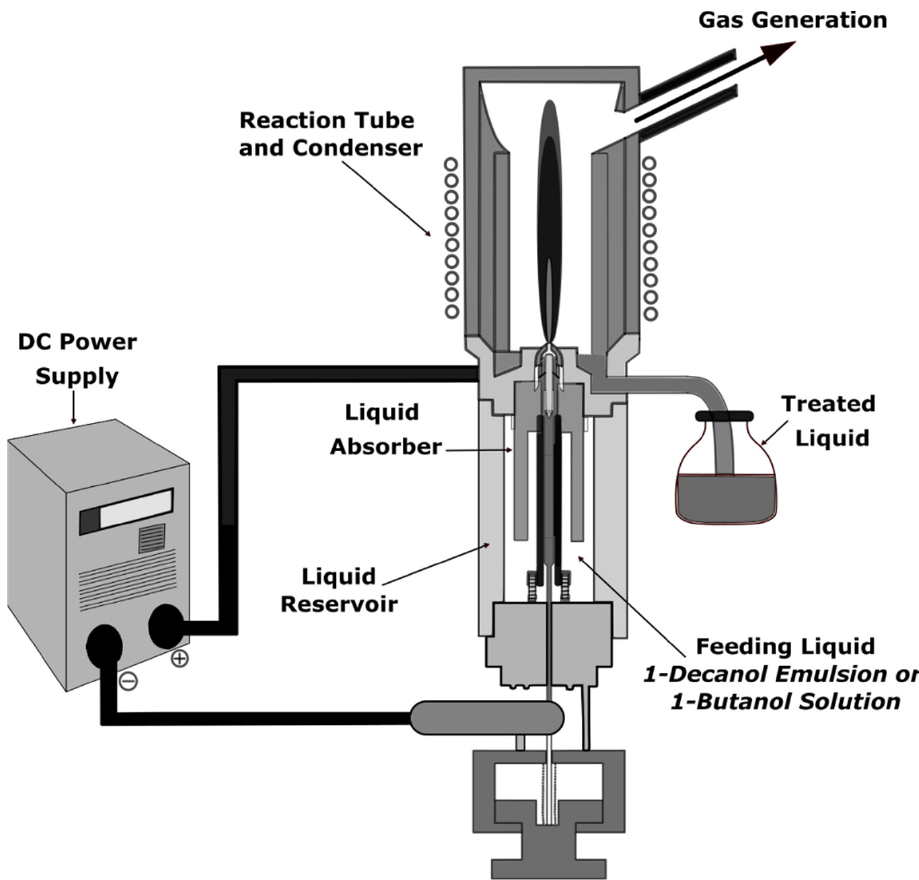
Figure 8. Atmospheric plasma jet setup for water purification.